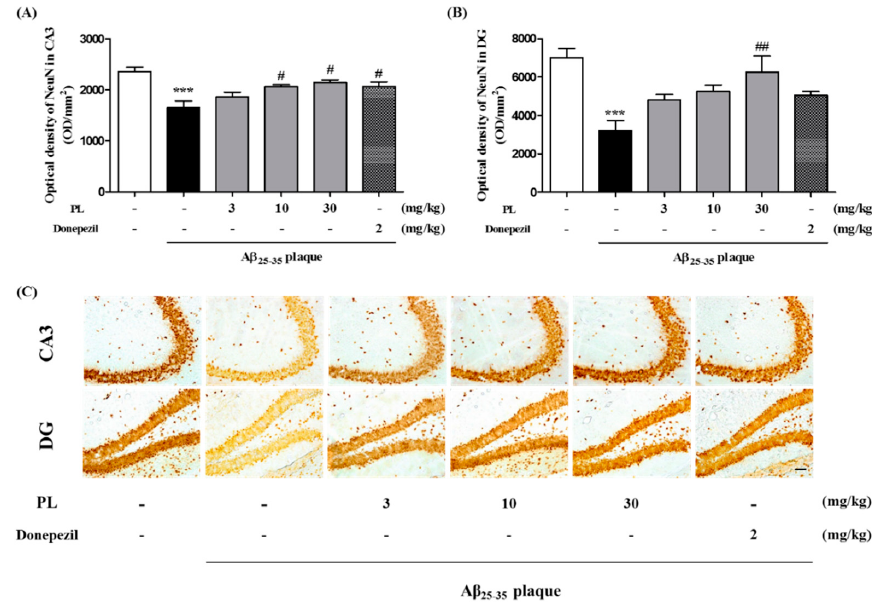
Figure 6. Effect of PL on neuronal cell loss in A β 25–35 plaque-injected mice. After stereotaxic injection of A β 25–35 plaque, mice were treated with vehicle, PL, or donepezil for 17 days. Neuronal cells were stained with anti-NeuN antibody. The optical density of the NeuN-stained cells was measured in the ( A ) CA3 and ( B ) DG; ( C ) Representative images of NeuN-positive neurons in the CA3 (up) and DG (down) of mice brain. Scale bar = 30 μ m. Values are mean ± standard error of the mean. *** p < 0.001 vs. sham group; # p < 0.05 and ## p < 0.01 vs. A β 25–35 plaque group. Donepezil was used as a positive control.